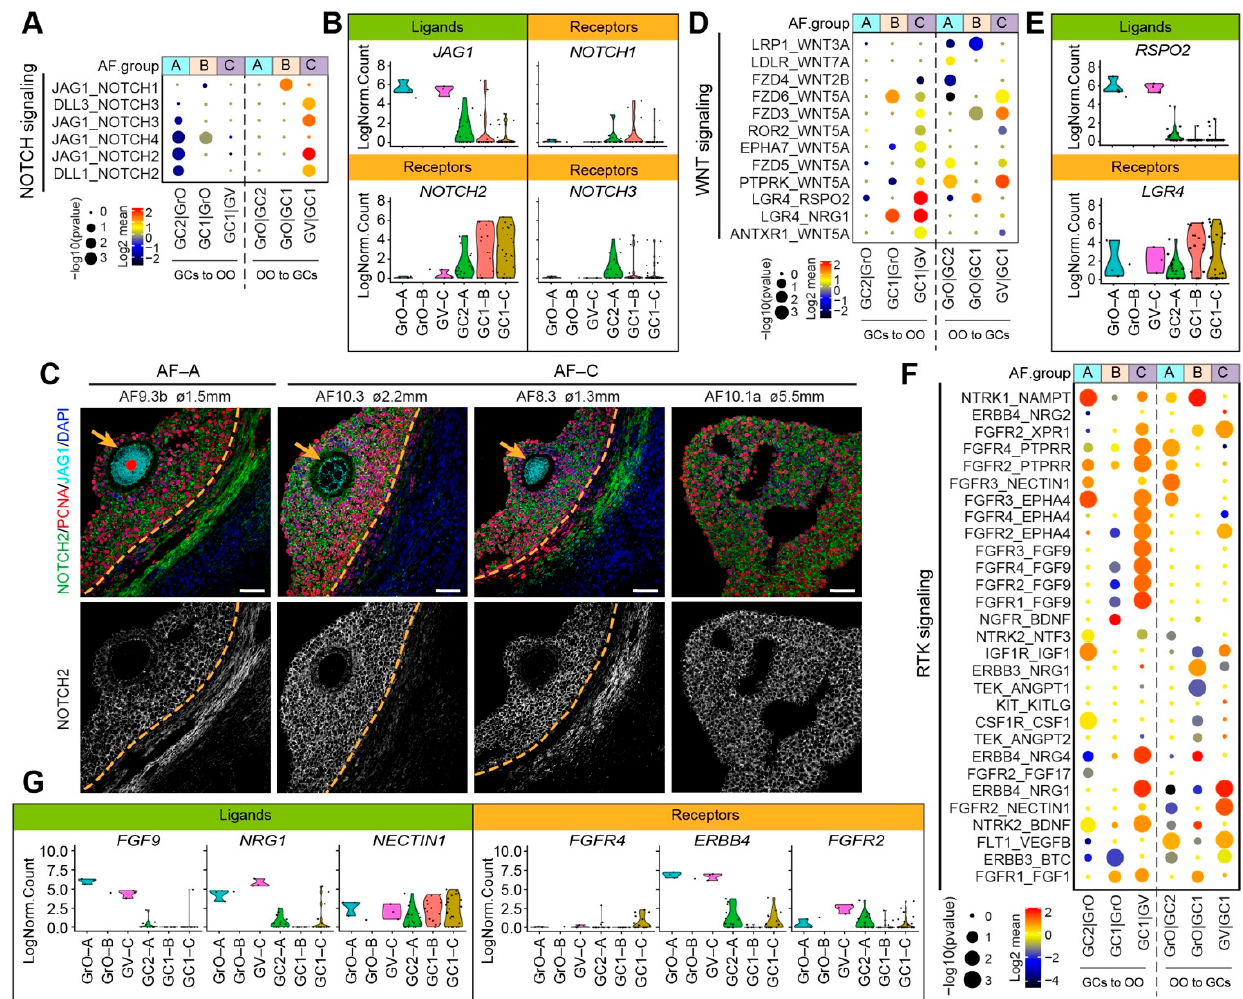
Figure 6. NOTCH, WNT, and RTK signaling ligand–receptor interactions in different types of small antral follicles. ( A ) CellphoneDB analysis of NOTCH signaling interactions between oocytes and GCs in different types of antral follicles; ( B ) Violin plots of selected NOTCH signaling ligand and receptor genes in OO.groups and GC.groups; ( C ) Immunofluorescence for NOTCH2, JAG1, and PCNA (top panels) and single channel for NOTCH2 (bottom panels) on small human antral follicles showing the follicle area close to the oocyte. Orange arrows indicate the oocyte. Orange dashed lines indicate the follicular basement membrane. ø, follicle diameter. Scale bars are 50 μ m; ( D ) CellphoneDB analysis of WNT signaling interactions between oocytes and GCs in different types of antral follicles; ( E ) Violin plots of selected WNT signaling ligand and receptor genes in OO.groups and GC.groups; ( F ) CellphoneDB analysis of RTK signaling interactions between oocytes and GCs in different types of antral follicles; ( G ) Violin plots of selected RTK signaling ligand and receptor genes in OO.groups and GC.groups.